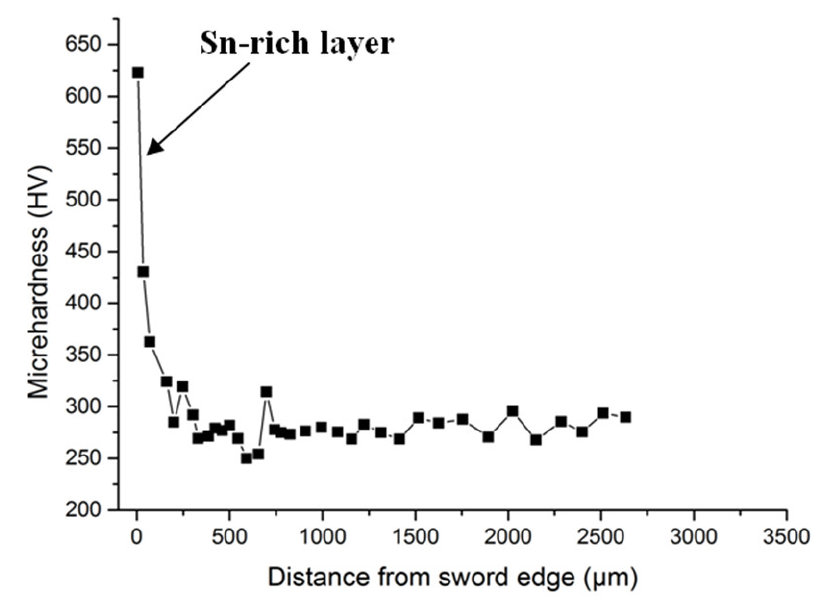
Figure 7. Vickers microhardness profile of the sword cross-section surface.